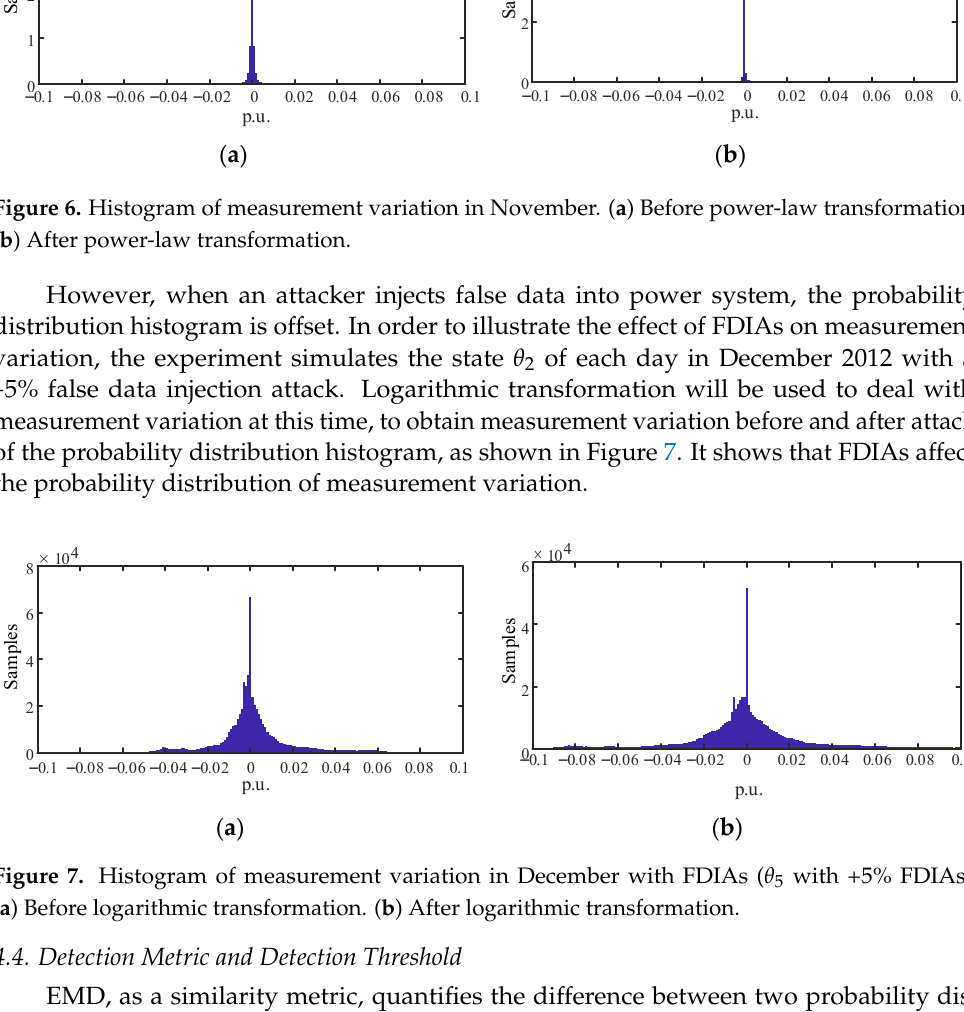
θ with +5% FDIAs). ( a ) 5